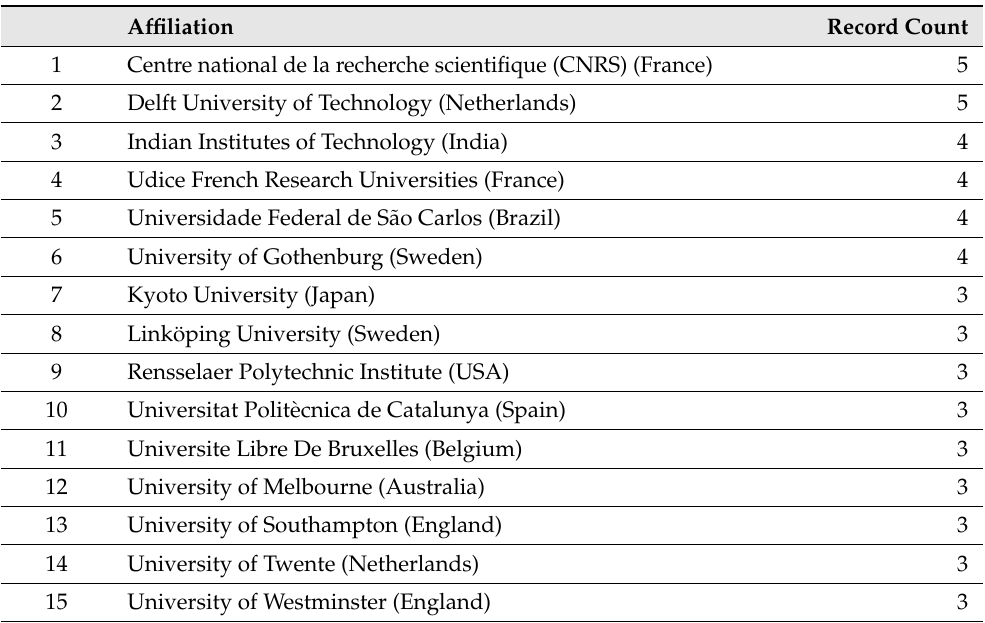
Table 3. Top affiliations out of 168